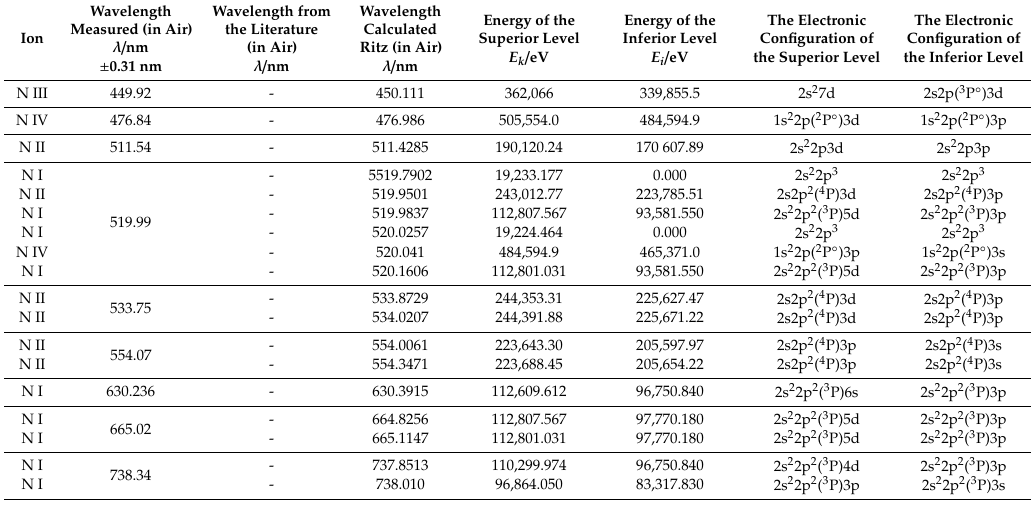
Table 3. Atomic nitrogen fluorescence (BPA in acetone solution with c = 1%).